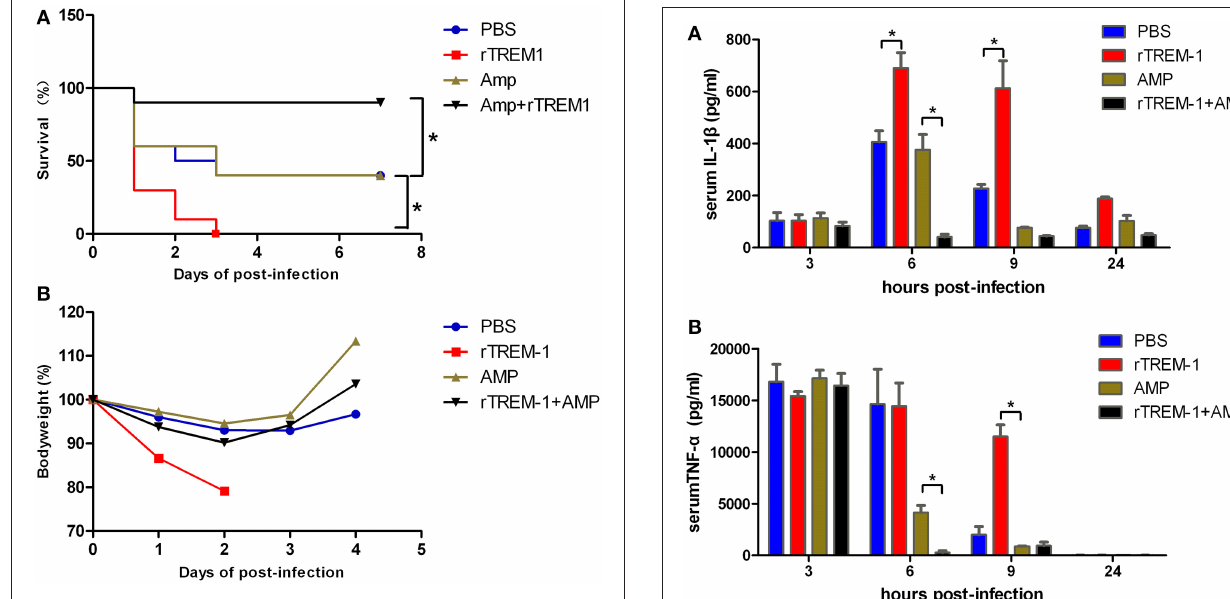
FIGURE 3 | Kinetics of serum IL-1 β (A) and TNF- α (B) in mice. Mice were infected with a highly virulent S. suis strain and then treated with PBS, rTREM-1, antibiotics, and antibiotics+rTREM-1 at 3h post-infection, and the serum TNF- α and IL-1 β were determined with commercial ELISA kits. “ * ” represents p < 0.05 for the two selected groups at the given